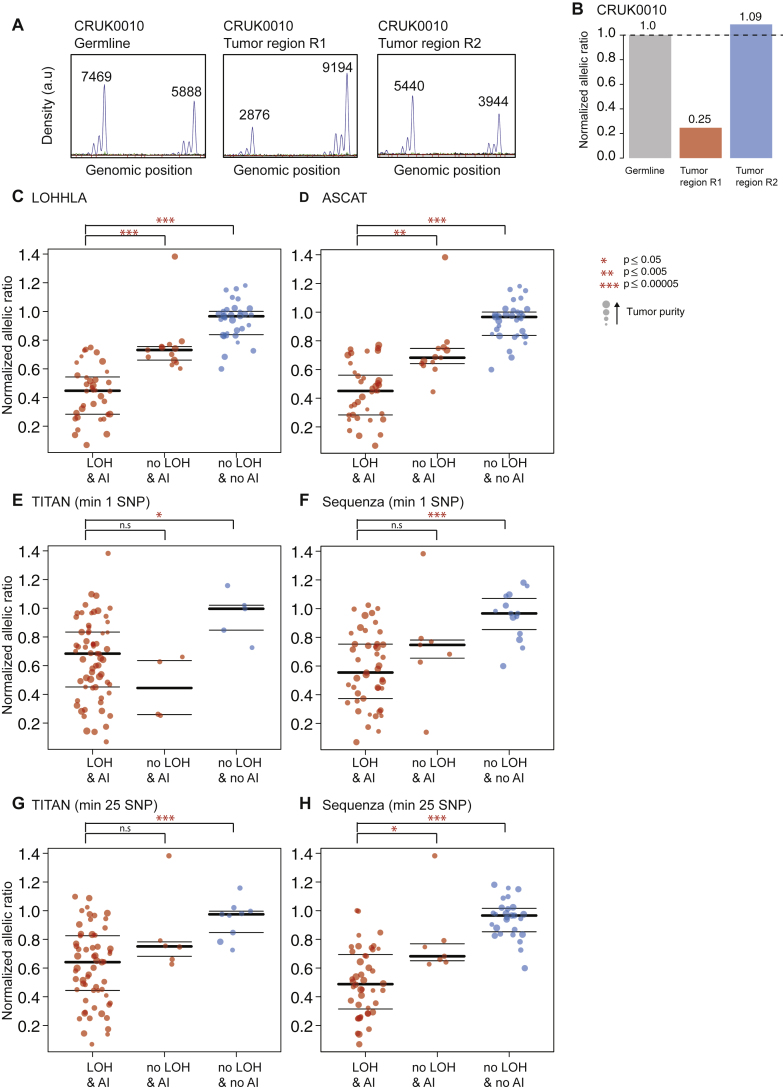
Validation of LOHHLA Using Fragment Analysis, Related to Figure 1(A) Area under the curve of each allele using the Applied Biosystems software GeneMapper v5 for germline and tumor regions R1 and R2 in CRUK0010.(B) Normalized allelic ratio determined using the formula (Atumor/Btumor)/(Anormal/Bnormal). Notably, region R1 shows clear evidence of allelic imbalance and likely LOH, while region R2 appears similar to germline.(C–H) Normalized allelic ratio for tumor regions showing either LOH and allelic imbalance; no LOH but allelic imbalance; or no LOH or allelic imbalance classified by LOHHLA (C), ASCAT (D), TITAN (E and G) and Sequenza (F and H). Tumor purity, as assessed by ASCAT is depicted for each tumor region, p values correspond to Wilcoxon rank sum test.